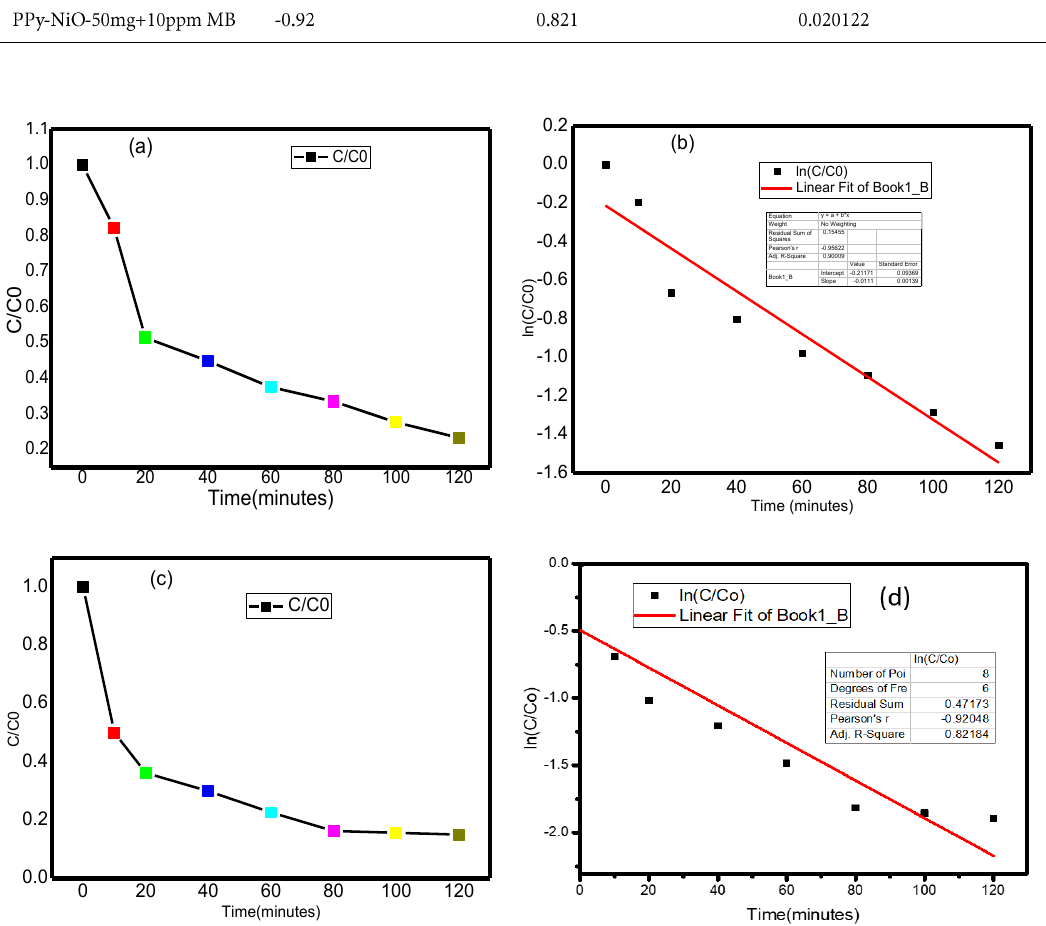
Fig. 6. Graphs for r and R square factor for 25 mg (a,b) and 50 mg PPy- NiO Fig. 6 (a,b,c,d)